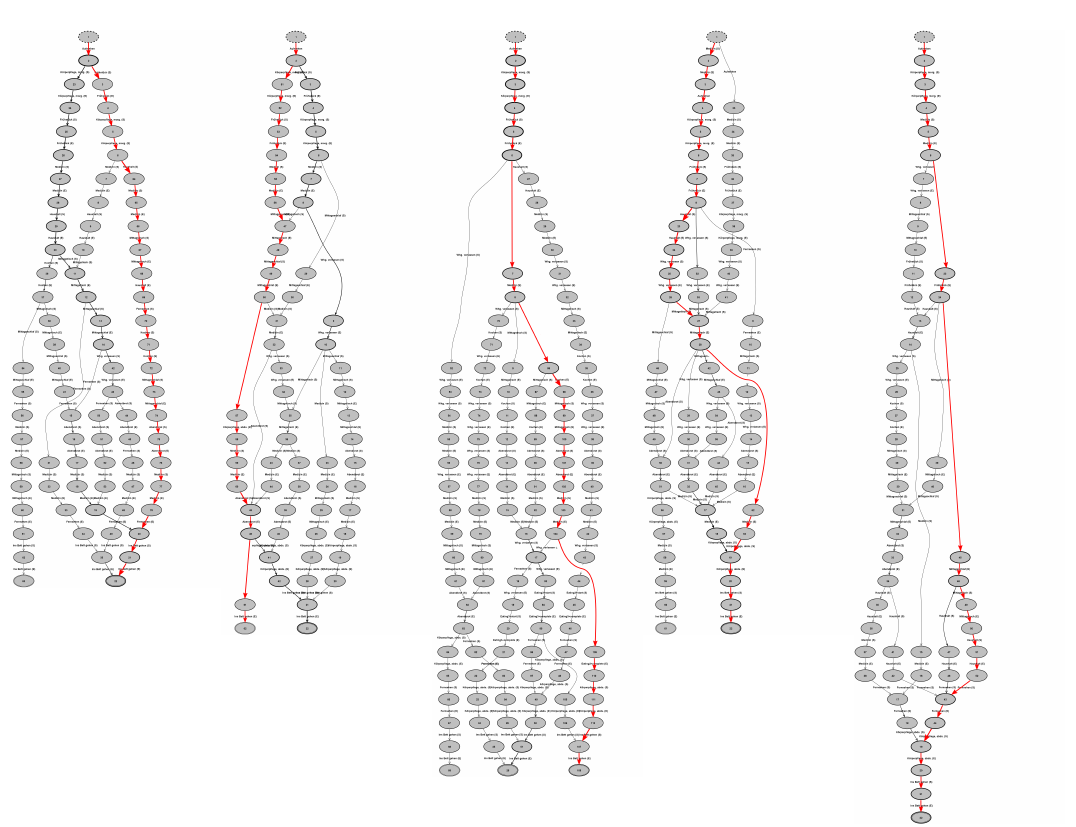
Figure 10. Typical daily behavior in terms of ADLs of five test persons P1–P5 (from left to